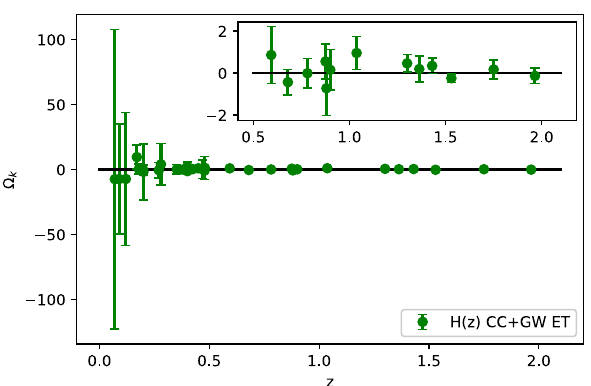
Fig. 7 31 measurements of the cosmic curvature parameter Ω k from the standard sirens of GW third-generation ground-based detector ET and cosmic chronometers. Inset in the upper right reveals more details